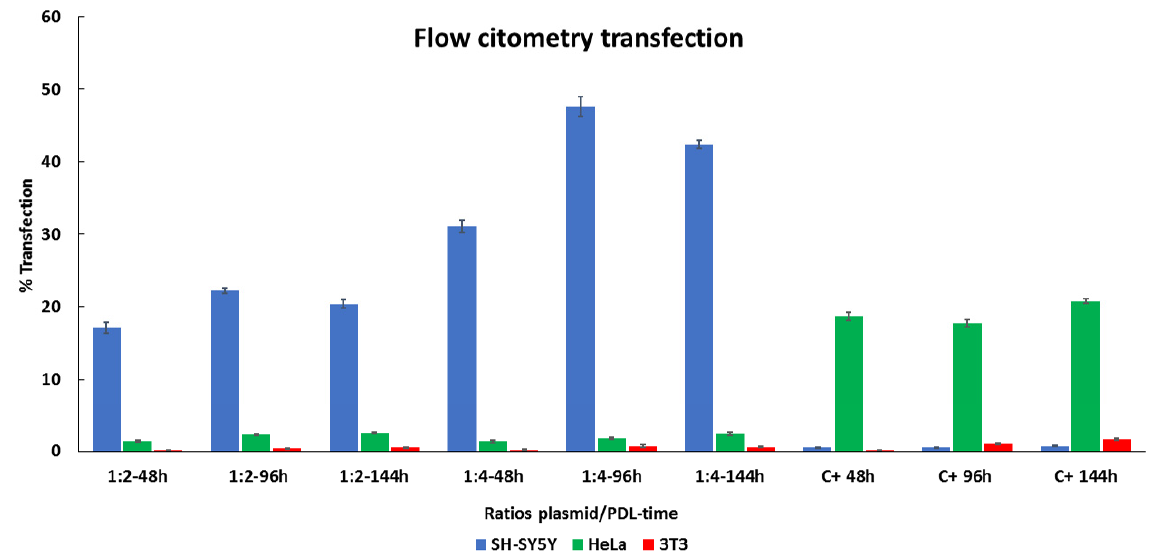
Figure 6. Comparing EGFP expression between PDL and lipofectamine determined by flow cytometry. SH-Sy5Y, HeLa, and 3T3 cells were treated three times (48, 96 and 144 h) with two different ratios of plasmid/PDL (ratio 1:2 and ratio 1:4) and with lipofectamine as a positive control (C+). Data are represented by mean +/ − SD of three distinct